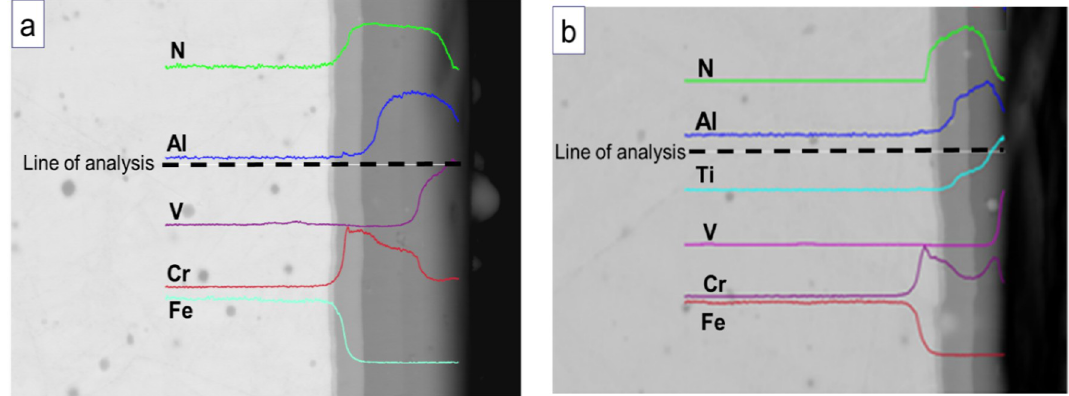
Figure 3. SEM / BSE images of cross-section and EDS profiles for P1 ( a ) and P2 ( b ) hybrid Figure 3. SEM/BSE images of cross-section and EDS profiles for P1 ( a ) and P2 ( b ) hybrid coatings.